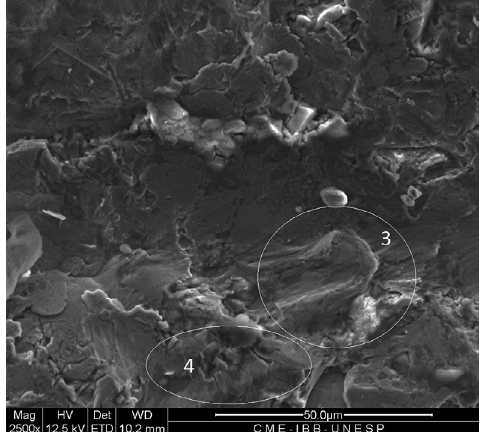
Figure 2. Surface of sample “R” after process of increasing roughness by blasting. In “3”, plastic deformation caused a drag of the surface material, while in “4” can be seen small cracks probably occurred due to the elevation of local stress.